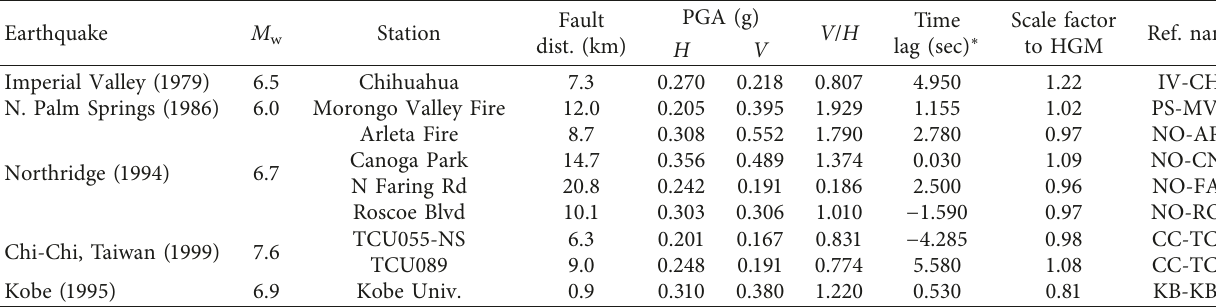
Figure 2: Limit states of SL6 frame: (a) serviceability and (b) damage control and collapse prevention. Table 2: Selected ground motions.